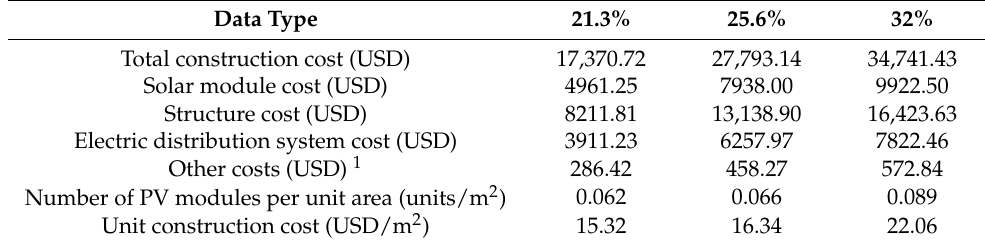
Table 1. Construction costs of an APV system (edited from Kim et al. [4]).